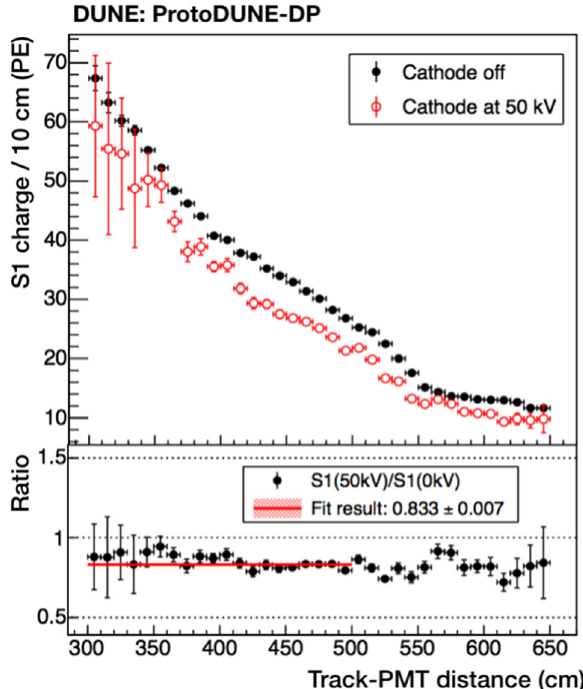
Fig. 17 Top panel: Average S1 charge collected by the PEN PMTs as a function of the track-PMT distance without drift field (black) and with cathode at − 50kV (red). The larger error bars at short distance are due toalackofstatistics.Bottompanel:Ratiobetweenthetwodistributions. The ratio is fitted to a constant value (result: 0.833 ±